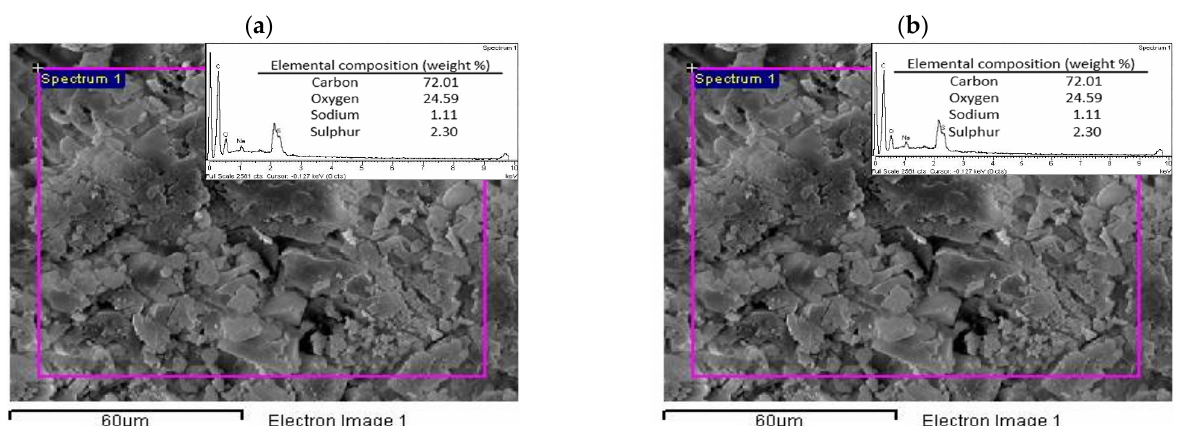
Figure 2. Energy-dispersive X-ray spectroscopy (EDX) spectra of the ( a ) eucalypt stump and ( b ) kraft lignin Table 2. Results of the elemental analysis of the isolated lignins (mass